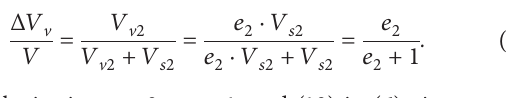
− V v s 2 curves under the same particle size